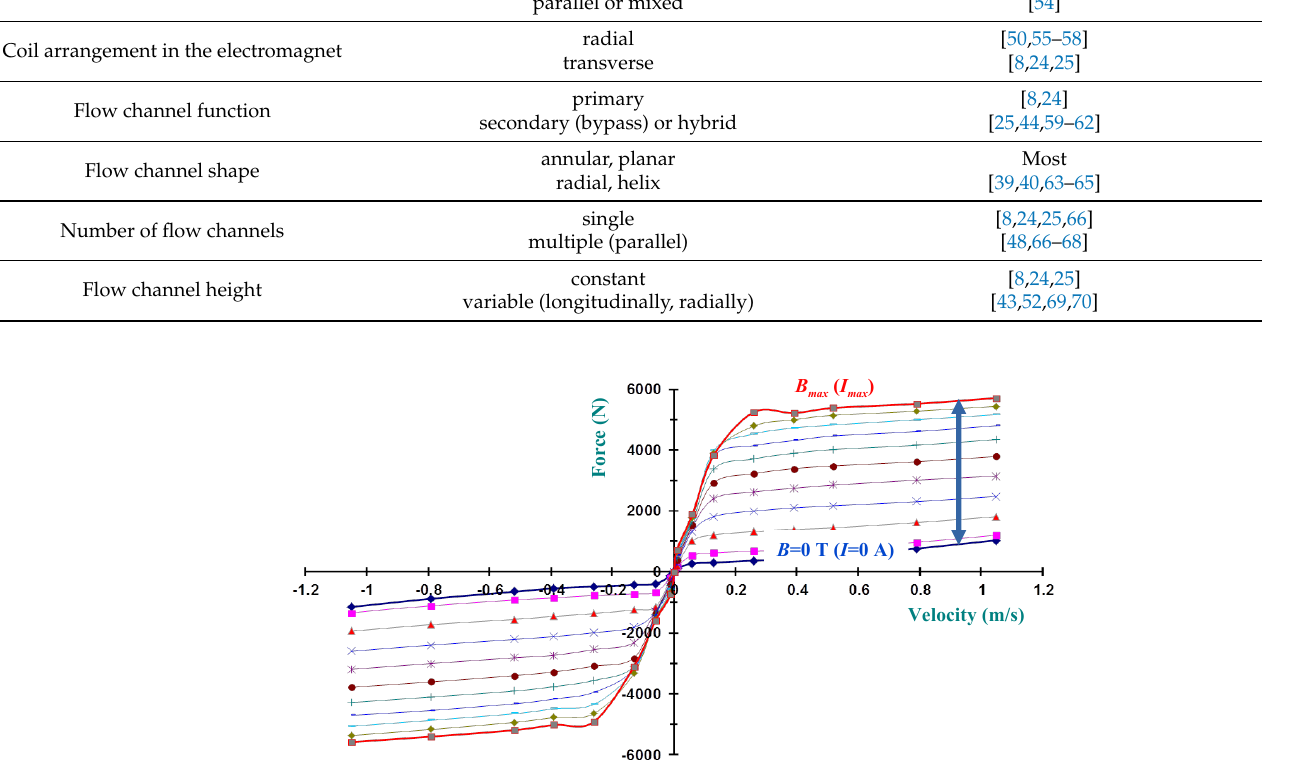
Figure 2. Example: static force–velocity characteristics (commercial actuator data courtesy of BWI Group); damping forces measured at fixed current levels from I = 0 to I max = 5 A in 0.5 A